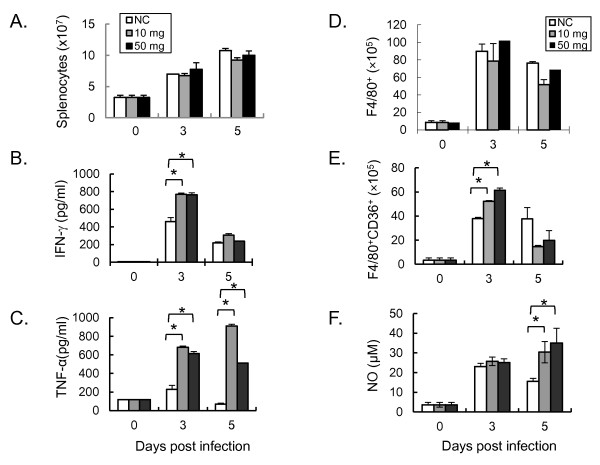
The effects of ABPS pretreatment on immune responses during early Plasmodium yoelii 17XL (P. y17XL) infection. Mice were injected i.p. with two different dosages of ABPS (10 mg/kg and 50 mg/kg) for consecutive 10 days prior to infection, and spleen lysates were prepared on days 0, 3 and 5 after infection. The control group (NC) received the same volume of physiological saline at the same time points. (A) Total number of splenocytes per mouse. (B) Levels of IFN-γ (C) Levels of TNF-α (D) Total number of F4/80+ macrophages. (E) Total number of CD36+ macrophages. (F) Concentration of NO2-. Values represent the mean with standard error (n = 3 mice per group). Results are representative of three independent experiments. Asterisk (*) indicates statistically significant difference (P < 0.05) between the control and ABPS pretreated groups of mice. Open, grey and black boxes indicate control group (NC), 10 mg/kg ABPS group (10 mg), and 50 mg/kg ABPS group (50 mg), respectively